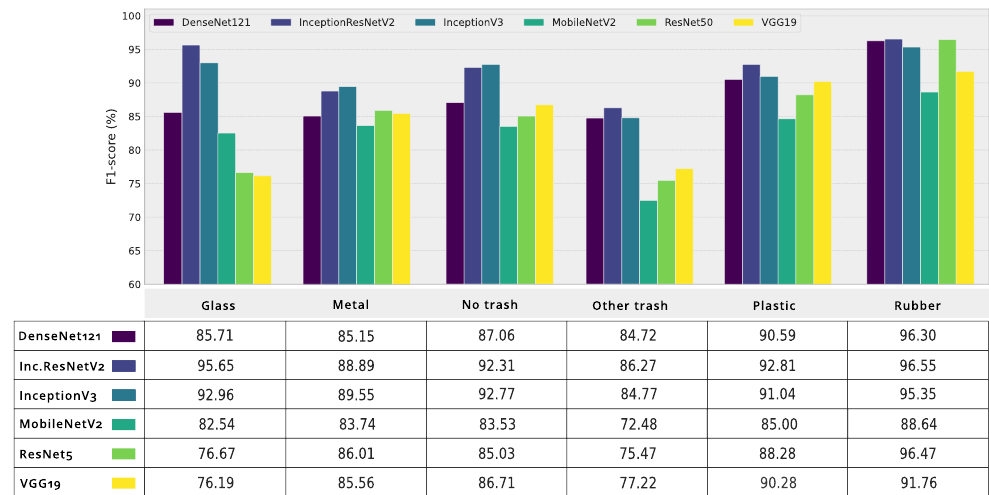
Figure 17. Two-dimensional t-SNE projections of Inception-ResNetV2 and MobileNetV2 features. In general, models obtain higher precision than recall, i.e., fewer false positives than false negatives per class. Figure 18 shows class-wise F1-scores for each deep CNN ar- chitecture. The weakest performance is observed on the Other garbage class with high in-class variations and the best in the Rubber class due to the unique round shape of class objects and lower range of in-class variations. Aside from the low performance in the Other Trash class, models that used the ResNet50 and VGG19 extractors did not show the best performance in the Glass class either.